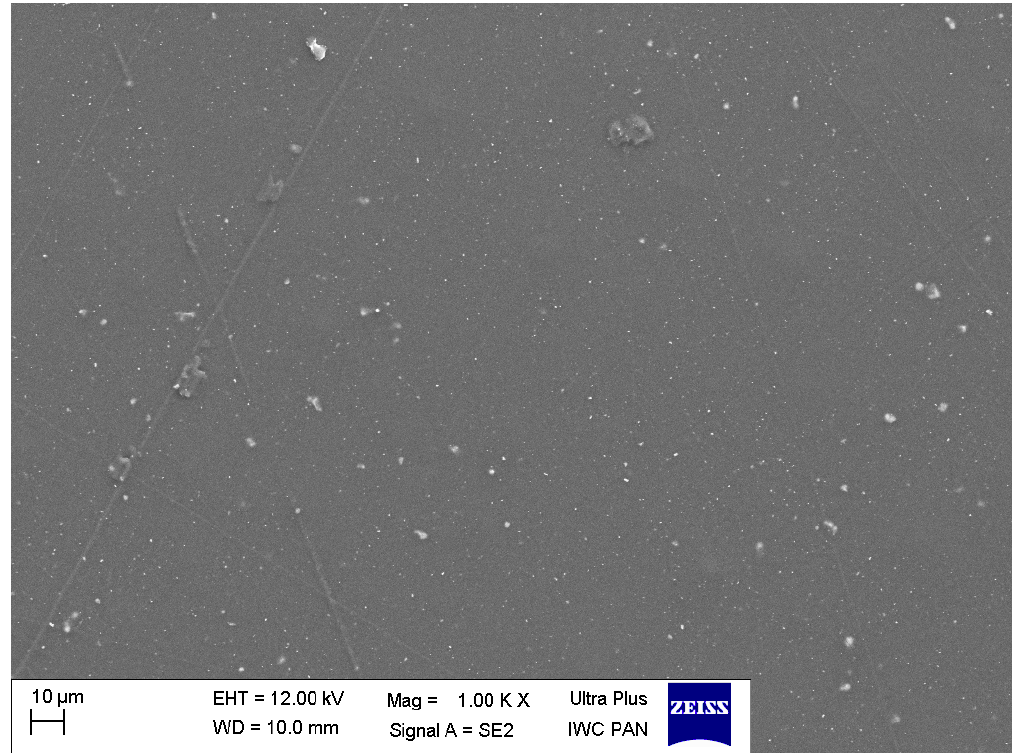
Figure 5. Representative SEM image of the nanocomposite (TiO 2 NPs Cp = 1 wt%).